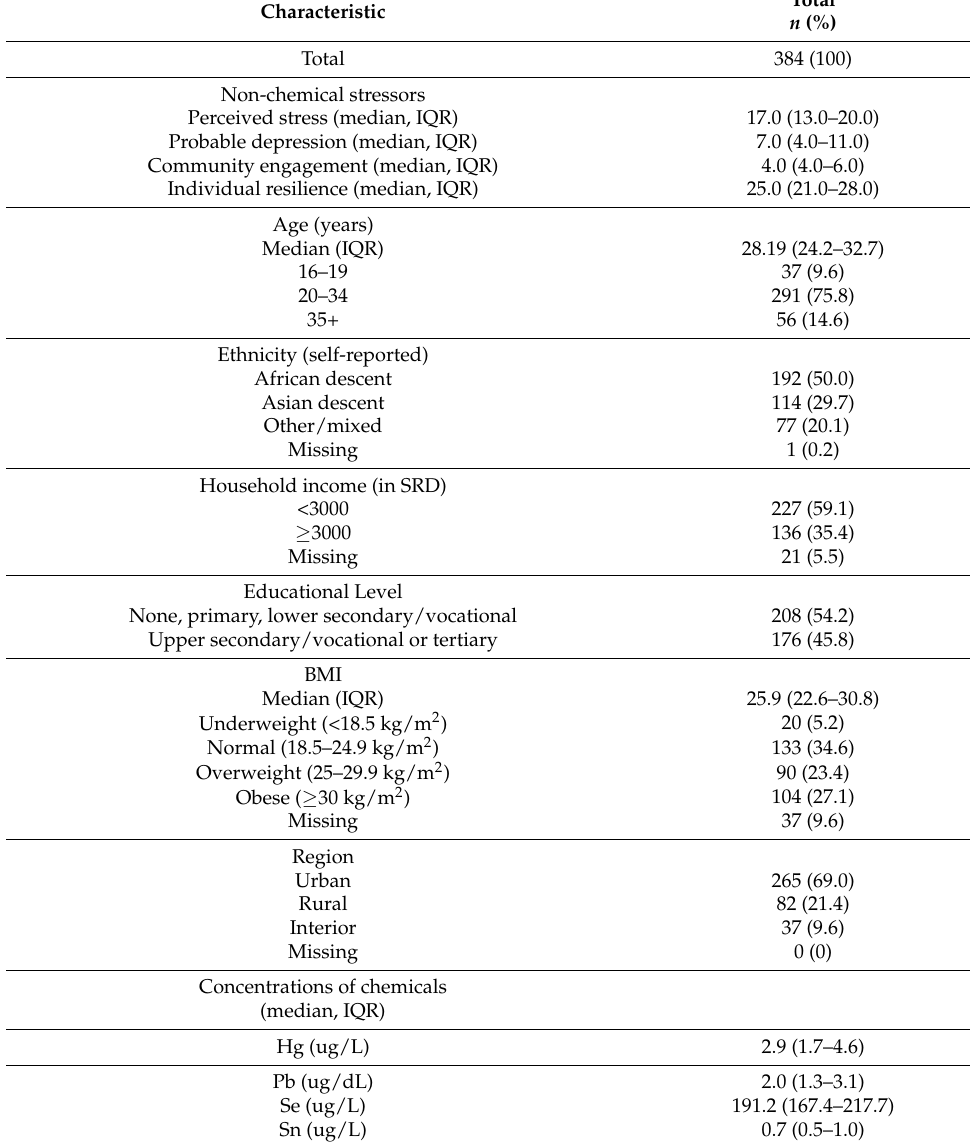
Table 2. Characteristics of the study